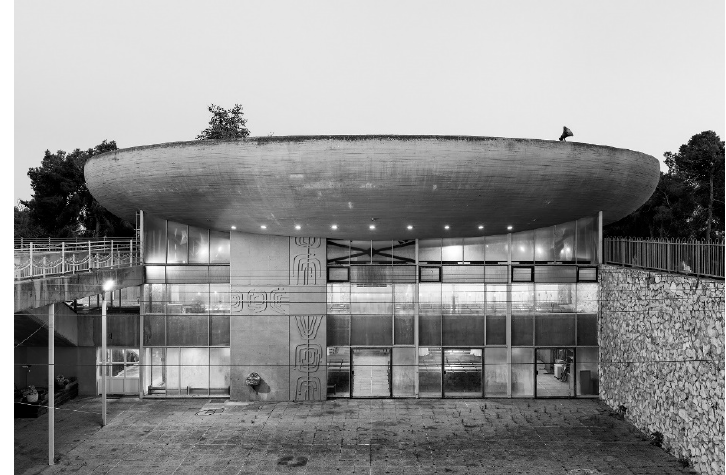
Figure 2. The Central Synagogue, Nazareth Illit. Architect: Nahum Zolotov, 1968. Photo: Eli Singalovski, 2018. Used with permission.